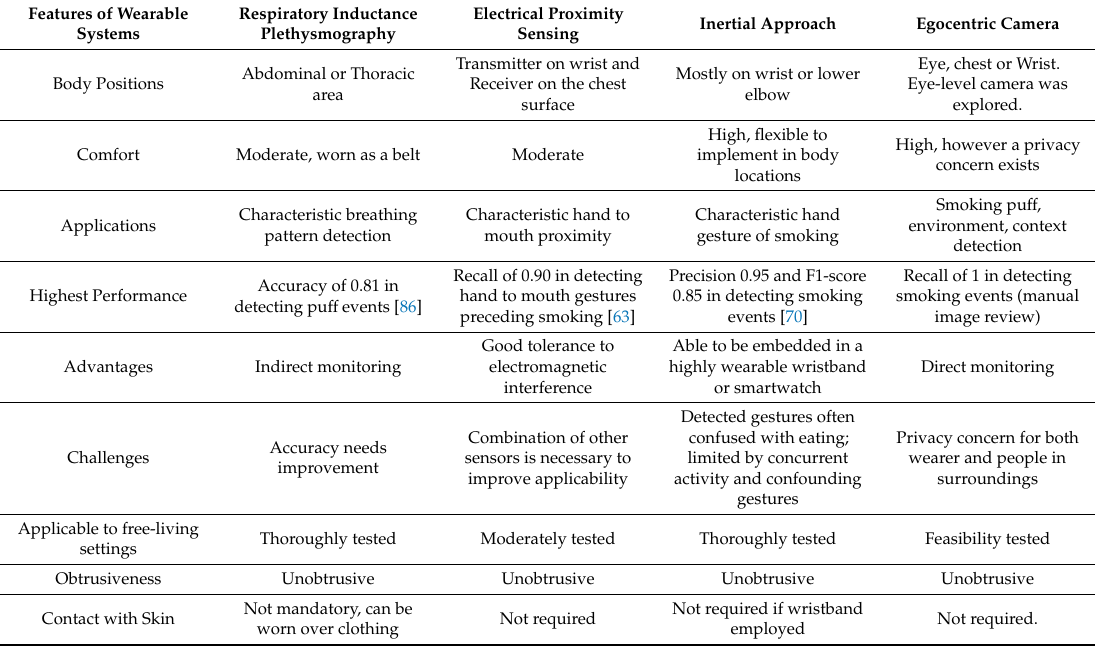
Table 12. The comparison of key sensing modalities employed in smoking